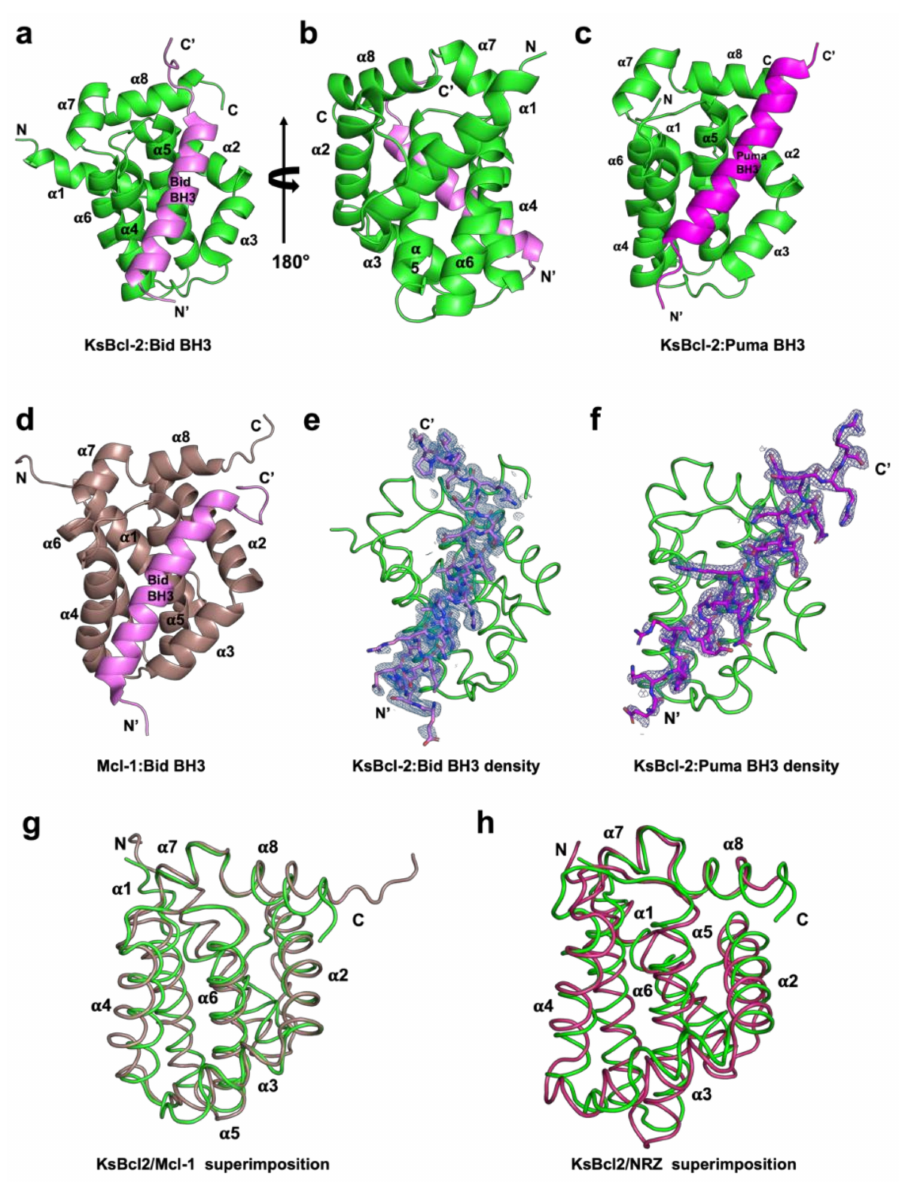
Figure 1. KsBcl-2 binds BH3 motif peptides of pro-apoptotic Bcl-2 proteins using the canonical ligand binding groove. Crystal structures of KsBcl-2 bound to Bid and Puma BH3 motifs. ( a ) KsBcl-2 (green) in complex with the Bid BH3 motif (magenta). KsBcl-2 helices are labelled α 1– α 8. The view is of